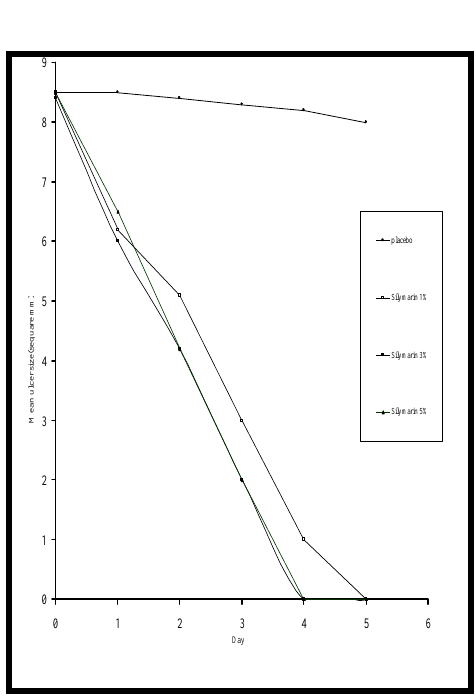
Figure 2. Effects of treatment with silymarin paste on the changes in ulcer size in HLU patients.All results are significantly different ( P <0.05) compared to placebo within 5